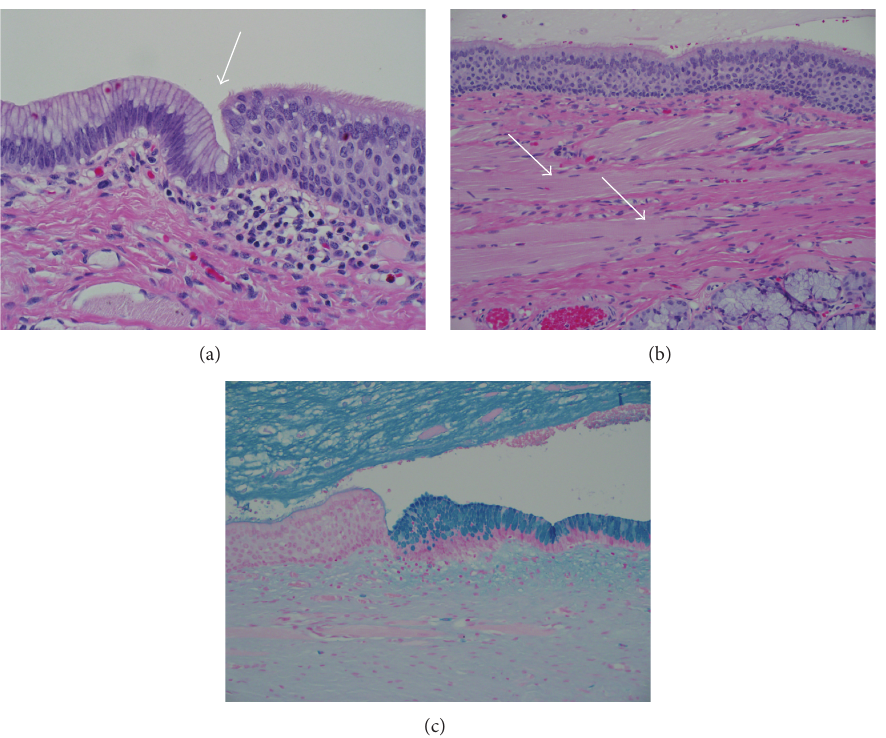
Figure 2: Histology. (a) Transition from respiratory-type ciliated pseudostratified columnar epithelium to gastric type epithelium (arrow). Hematoxylin and eosin, magnification at 400x. (b) The predominant epithelium of the cyst lining is respiratory-type ciliated pseudostratified columnar epithelium. Note the abundance of skeletal muscle with obvious cross striations in the cyst wall (arrows). Seromucinous glands are also present in the cyst wall (bottom right). Hematoxylin and eosin, magnification at 200x. (c) Alcian blue stain highlights the gastric epithelium while the adjacent respiratory-type epithelium is for the most part negative. Magnification at 200x.